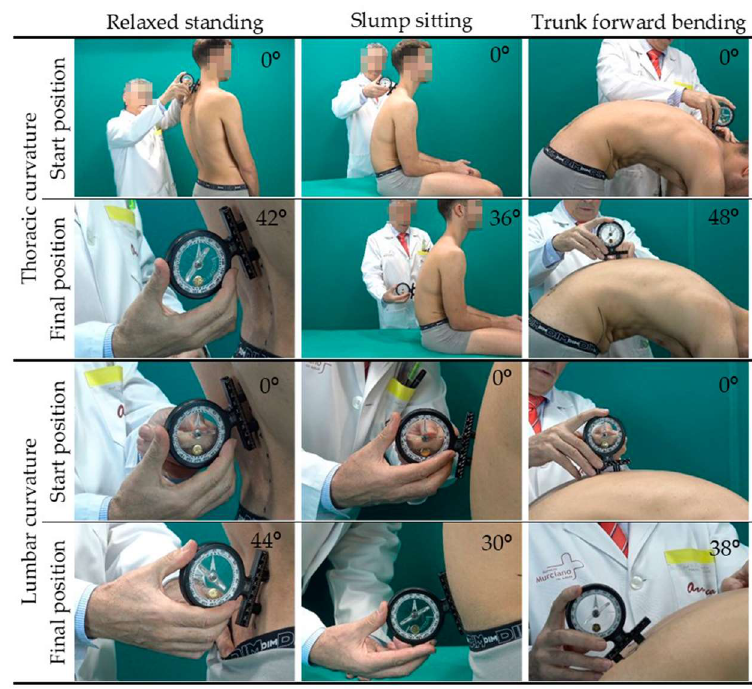
Figure 1. Tests for the assessment of the sagittal integral morphotype [40].